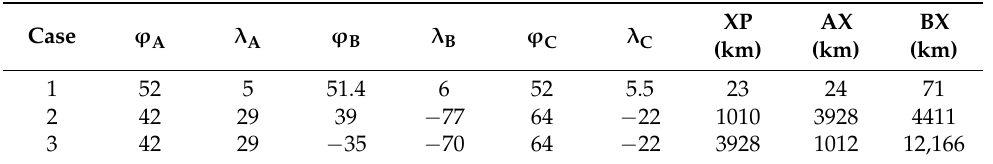
Table 5. Examples for the minimum distance tests. ϕ and λ denote latitude and longitude, in degrees, for points A, B and C, respectively.